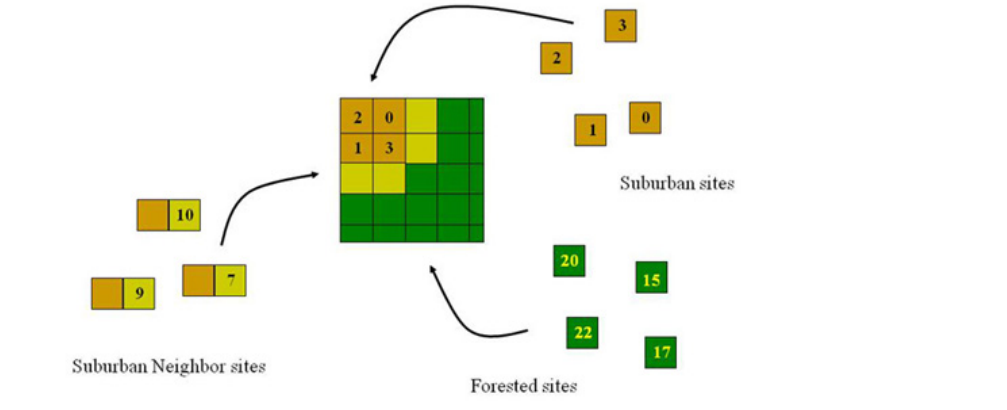
Fig. 4 . Illustration of the method for estimating the abundance of a carabid beetle species in a development scenario. Shown is the Semi-compact scenario (see Fig. 3; not to scale). Numbers represent the relative abundance of the species in each beetle survey site, calculated from pitfall trap data. Three types of beetle survey sites make up the Semi-compact scenario: Suburban, Suburban Neighbor, and Forested. For each site area in the scenario, a relative abundance value was randomly chosen from those of the replicate beetle survey sites in the appropriate housing category. To illustrate this, the developed portion of the scenario has been filled in with randomly chosen relative abundance values from the Suburban beetle survey sites. For areas in the development scenario that were smaller than site areas, the relative abundance value was multiplied by the proportion of a site area represented. Finally, the randomly selected values for the entire Semi-compact scenario were summed to yield an estimate of the abundance of the carabid beetle species in the whole development